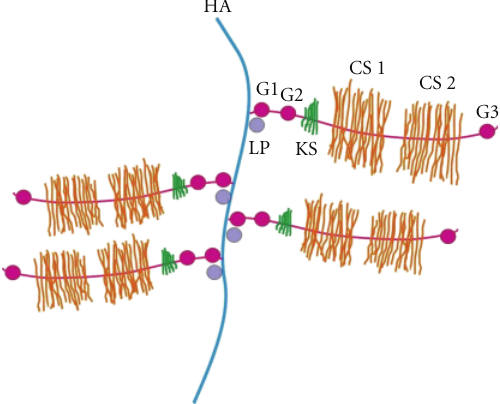
Figure 1: Schematic representation of the aggrecan structure (HA: hyaluronic acid, CS 1, CS 2: chondroitin sulfate domains 1 and 2; KS: keratan sulfate; G1, G2, G3: globular domains; LP: link